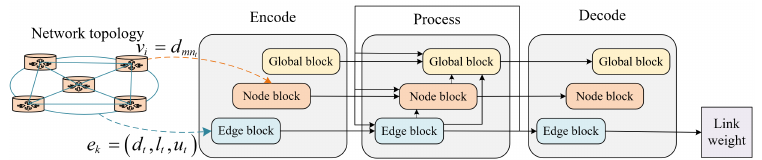
Figure 5. Mapping and updating process of network topology to